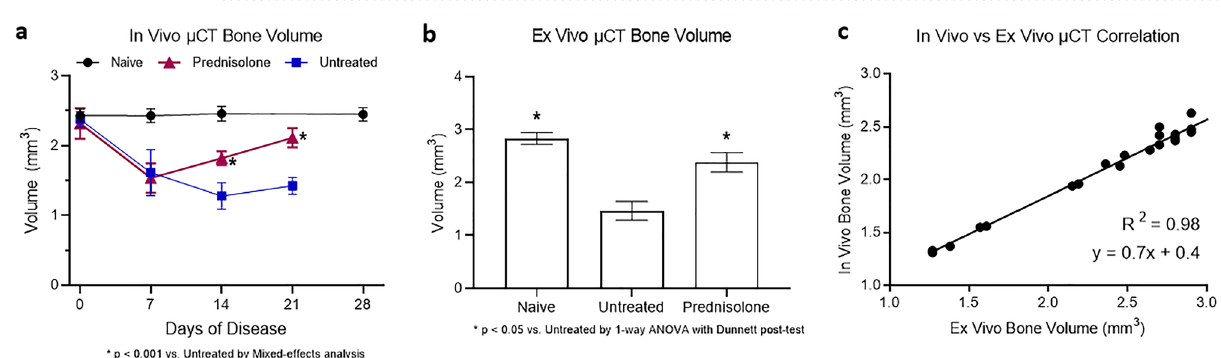
Figure 4. ( a ) In vivo µCT imaging measures tarsal region bone volume over time with n = 20 for naïve and n = 6 for other groups, ( b ) Ex vivo µCT imaging measures tarsal region bone volume with n = 10 for naïve and n = 6 for other groups. The same animals used for in vivo imaging were subsequently used for ex vivo imaging on day 21 of disease. ( c ) In vivo and ex vivo imaging-derived bone volume measurements of the tarsal region are correlated here, including animals from all groups, totaling n = 21. The linear regression performed indicates the correlation has an R-squared value of disease, followed by a reduction in STV with treatment (Fig. 3b). Prednisolone treatment resulted in decreased STV as compared to the untreated group (Day 21 treated 10.7 ± 0.8 mm 3 vs untreated 19.5 ± 2.4 mm 3 , p = 0.0004). Tarsal bone volume data were collected to assess disease-associated bone erosion. The pattern as seen in caliper measurements of worsening disease through the first week, followed by improvement in the treatment group, was mimicked by the in vivo and ex vivo BV data. As shown in Fig. 4a, disease progression resulted in decreased BV in both diseased groups, followed by an increase in BV in the treatment group as compared to the untreated group (Day 21 treated 2.1 ± 0.1 mm 3 vs untreated 1.4 ± 0.1 mm 3 , p < 0.0001). Further, the bone volume of the prednisolone treatment group increased from Day 7 to Day 21 (p = 0.002), demonstrating an effect greater than simply protection against worsening disease. Ex vivo BV data allows for confirmation of the in vivo imaging analysis methods. Figure 4b demonstrates the significant increase in BV on day 21 in the prednisolone treat- ment vs. untreated group (p < 0.0001). Further, the Day 21 ex vivo BV data agree well with Day 21 in vivo BV data (R-squared value = 0.98) (Fig. 4c). While the ex vivo and in vivo data sets have a highly linear correlation, the equation of the regression line is y = 0.7x + 0.4, where y is the in vivo data and x is the ex vivo data. This 30% difference in slope from 1 may be due to the spacing between the tarsal bones changing postmortem and during the processing steps prior to being mounted onto the Scanco µCT scanner for ex vivo imaging. 3-D reconstruc- tion of representative in vivo µCT images from each group on Day 21 are shown in Fig. 5. In comparison to a naïve sample with a smooth surface (Fig. 5a), these images qualitatively demonstrate disease-driven bone ero-